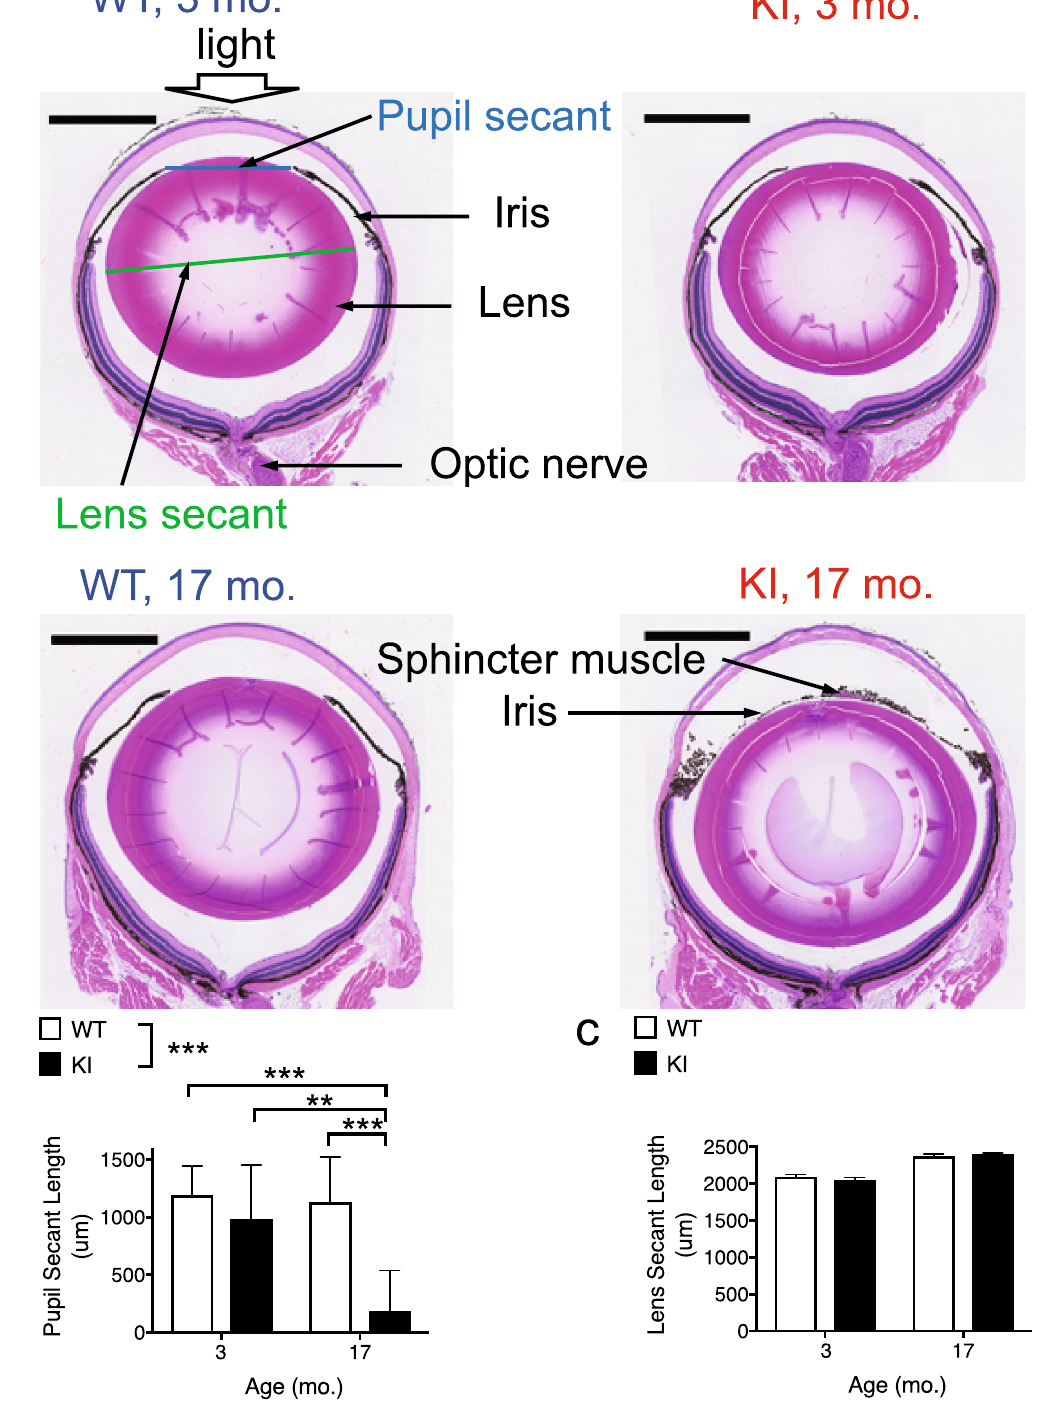
Figure 3. Pupil dilation deficits in aged Gba KI mice are apparent post mortem. ( a ) Representative images taken from sagittal cross sections through the globe at the level of the optic nerve in 3- versus 17-months old Gba KI and WT mice. The picture to the upper left illustrates the path of the light into the eye (from top to bottom), and indicates how pupil secant length and lens secant length, proxy measures for the size of the pupil and the lens, respectively, were derived from the histological sections. In the picture of the aged KI mouse (bottom right) the sphincter muscle of the iris is visible, indicating that the cross section is in close proximity to the center of the pupil, but no pupil opening is apparent. This indicates that the pupil is either completely closed, or that the center of pupil is not perfectly located in this histological plain, and that the size of the pupil opening is so small that a pupil secant cannot be detected in this plain. Pupil secant length ( b ). Lens secant length ( c ). The scale bar denotes 1000 µm. Asterisks denoting significance levels for main effects of genotype are indicated next to the genotype symbols above the graphs; those for post-hoc tests between individual genotype- and age-combinations are indicated within the graphs. Main effects of age are not indicated. * p < 0.05, ** p < 0.01, *** p < 0.001. Values are mean ±